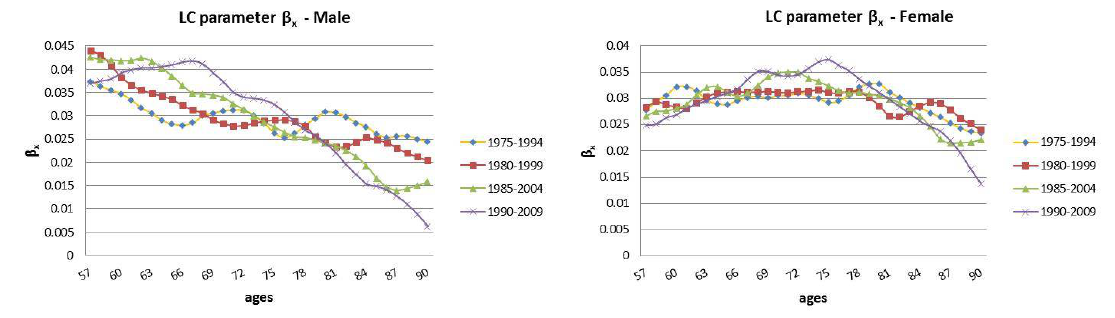
Figure 11. LC Jumping Fixed-Length-Horizon: β x parameter estimates.